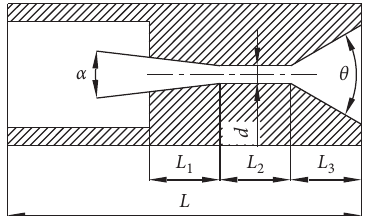
Figure 1: Geometry structure of the nozzles used in the experiment and